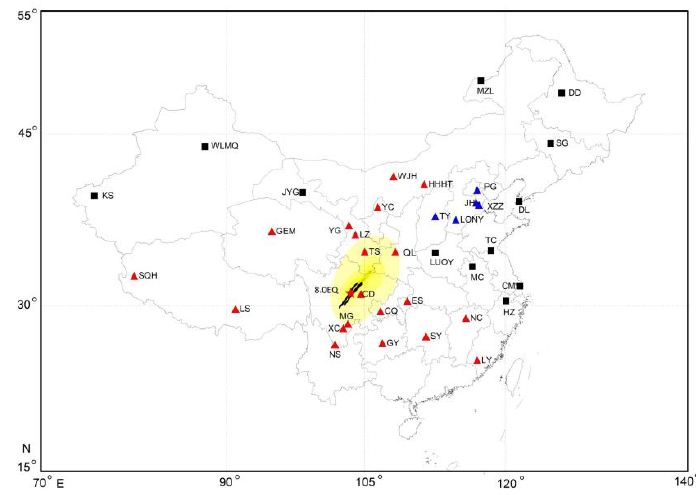
Figure 3. Locations of the geomagnetic observing stations in China during the Wenchuan M S 8.0 EQ. Red triangles represent geomagnetic stations registering “double low-point” anomalous phenomena in the vertical Z on 9 May 2008 and blue ones represent stations recording these phenomena on 8 and 9 May 2008. Black squares are stations which did not record this kind of anomaly during the period of 20 April–12 May 2008. The location of the Wenchuan M S 8.0 EQ is indicated by a red star.